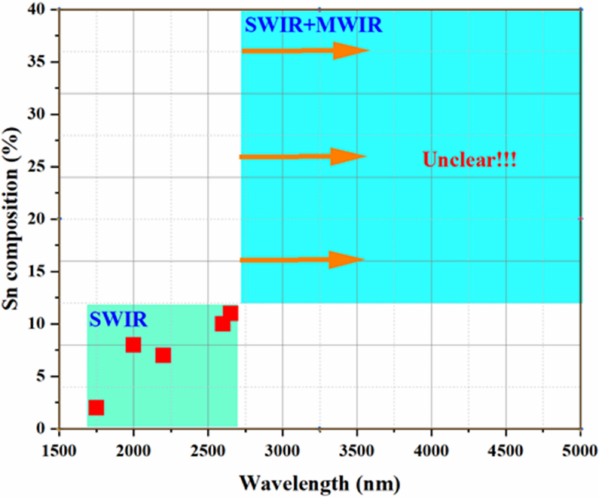
Figure 23. Sn content vs. cut-off wavelength of the GeSn PIN